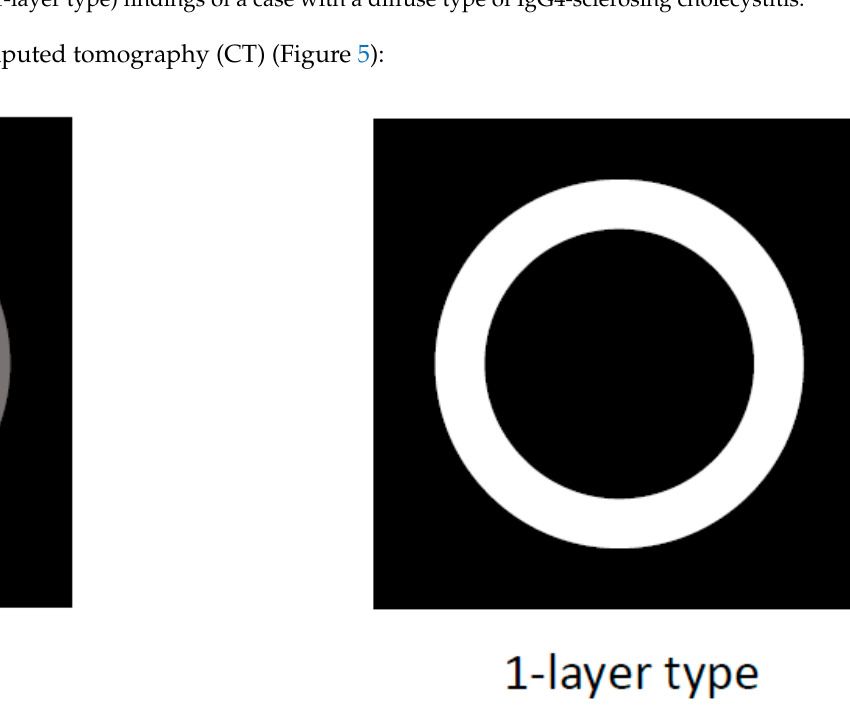
Figure 5. Schema of CT findings in a diffuse type of IgG4-sclerosing cholecystitis. A diffuse type IgG4-CC could be classified into 2- and 1-layer